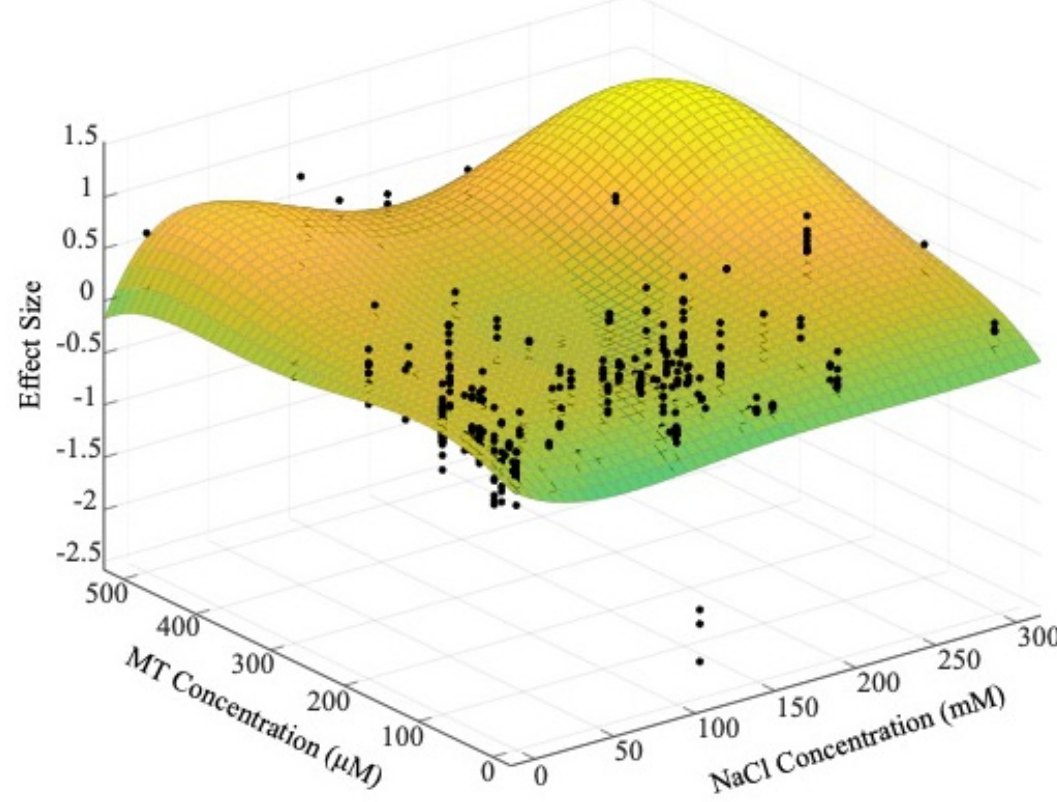
Figure A3. The surface graph formed by the effect size after five − dimensional fitting. Table A1. Overview of the studies used for this meta-analysis.